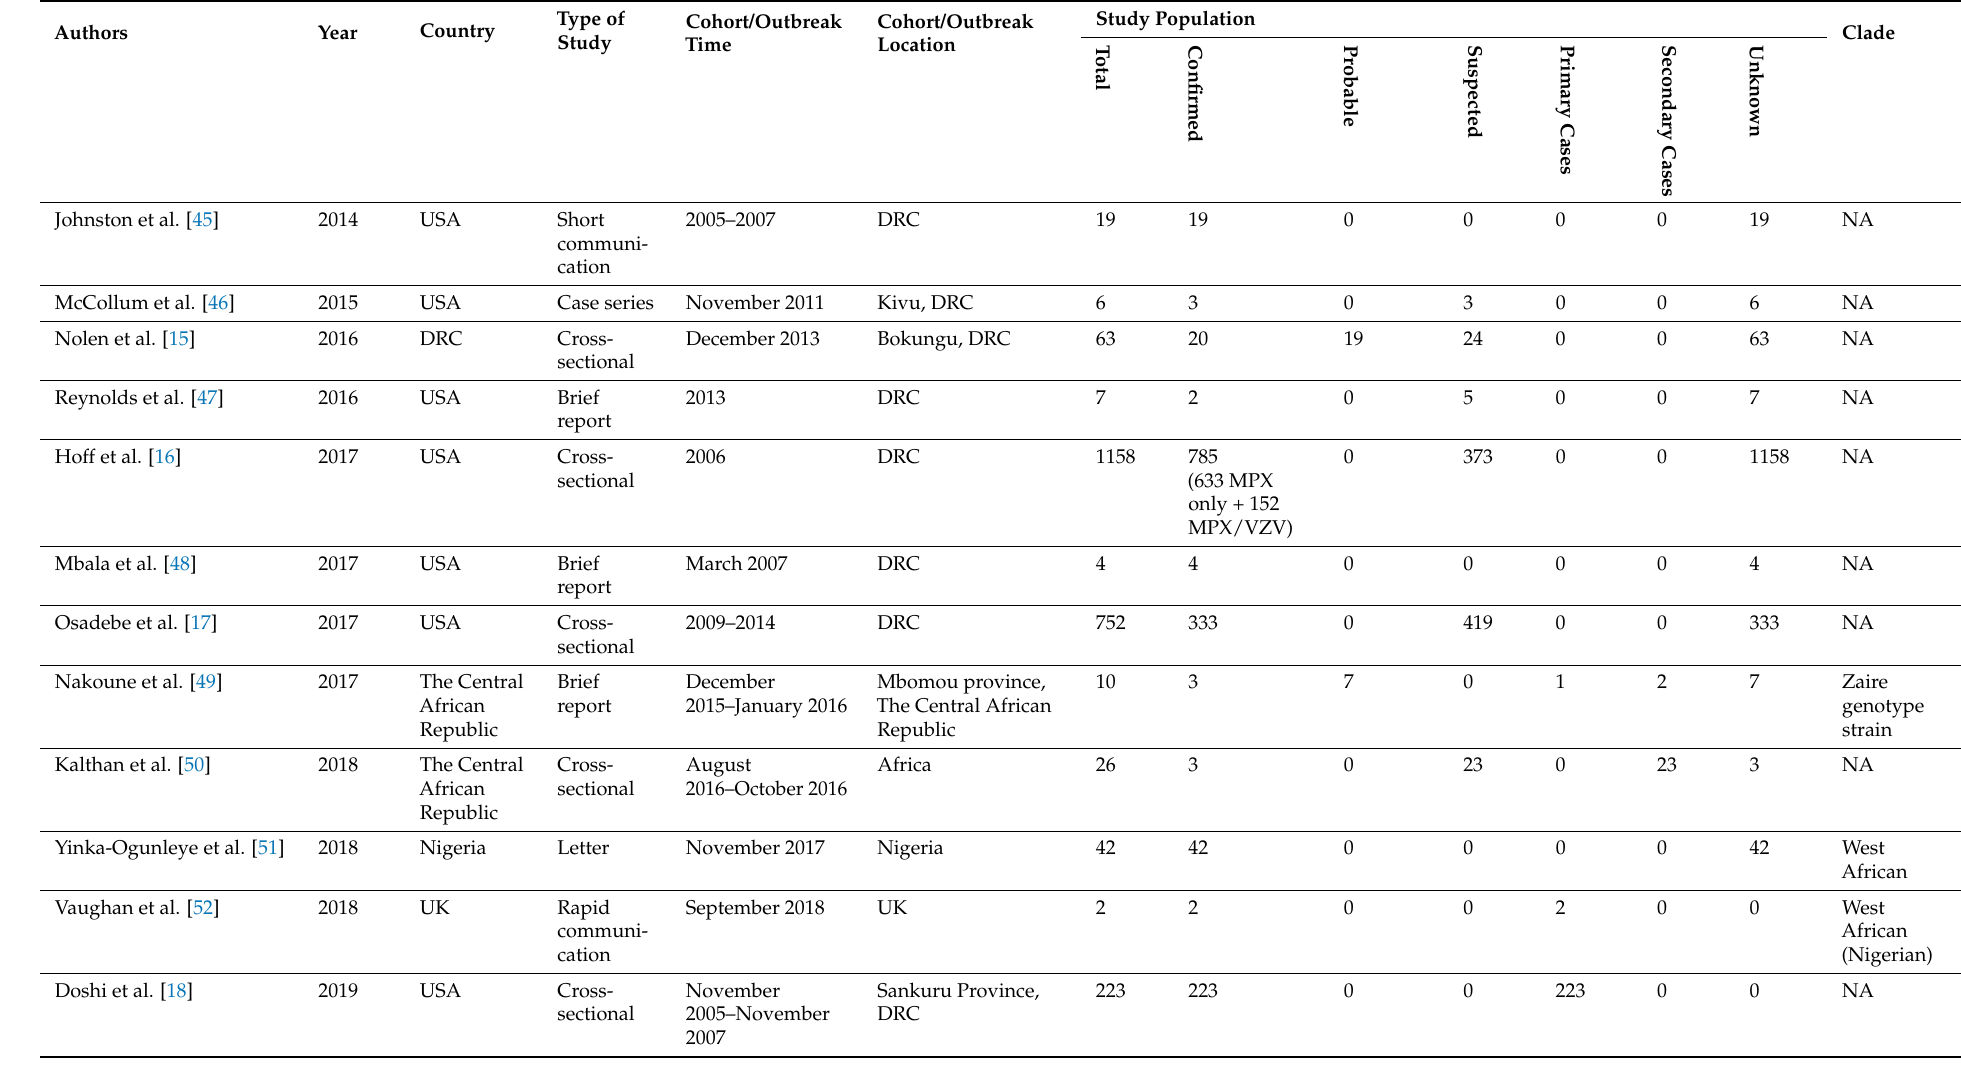
Table 2. Characteristics of the included